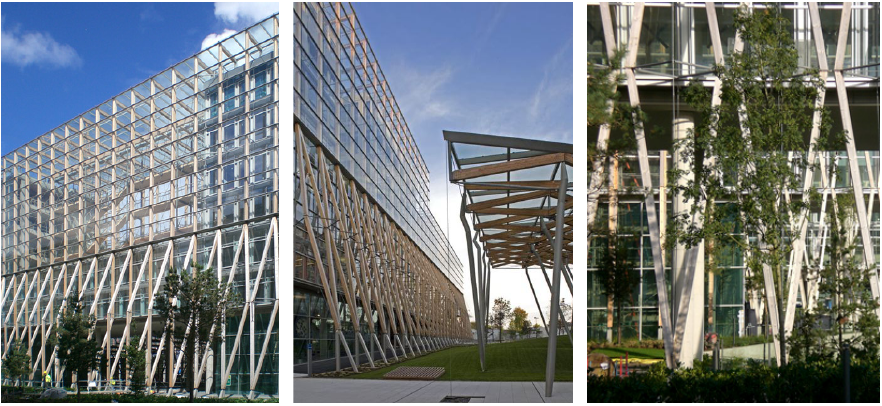
Figure 5,6 and 7: Double façade of the Elm Park